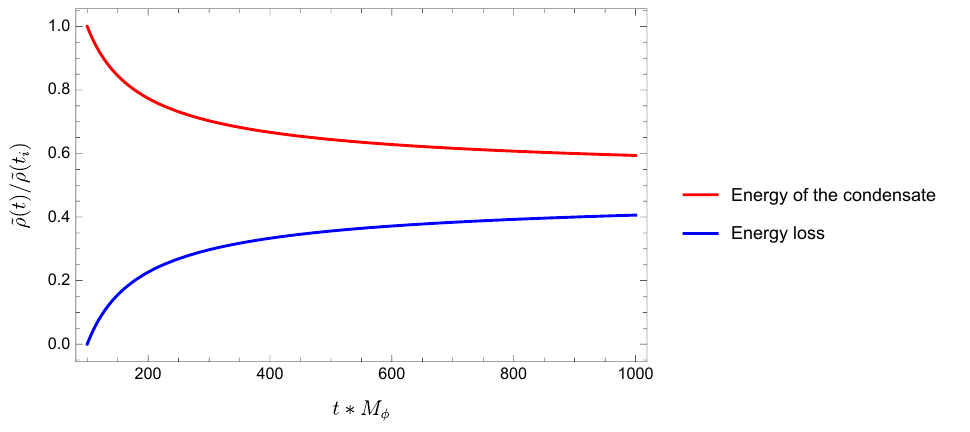
Figure 4 . Energy transfer from the condensate to the produced particles in a radiation-dominated universe without the self-energy correction. The evolution of the condensate comoving energy density and of the energy loss are drawn in the red and blue lines, respectively. Compared with figure 2, the energy transfer from the condensate to the produced particles in a radiation-dominated universe is inefficient in absence of the γ